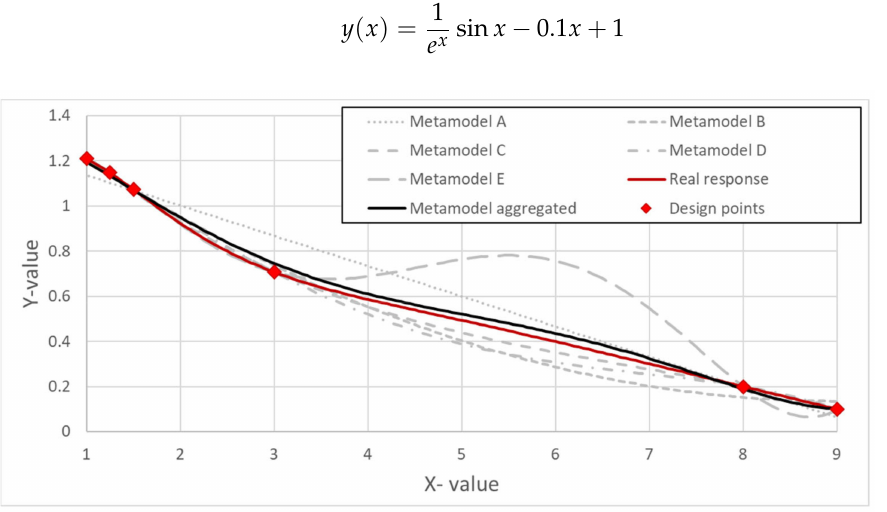
Figure 9. Aggregated metamodel example for 1D function.